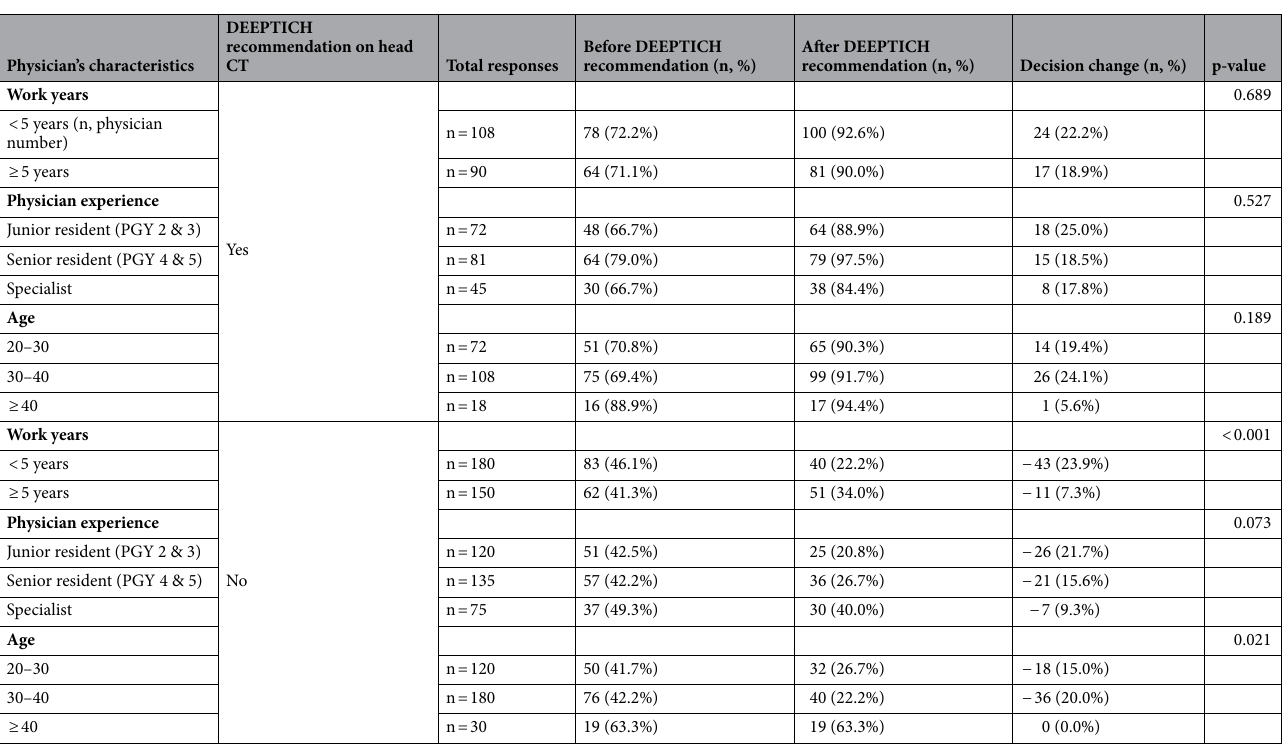
Table 2. Changes in the decision to order a head CT based on the physician’s characteristics. n (%) of physicians who answered ordering a head CT. Post hoc analysis. 30–40 vs ≥ 40, p <